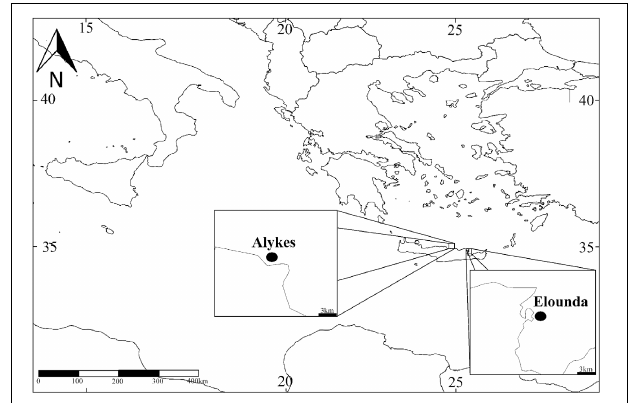
FIGURE 1 | Map of the study sites, located in Crete: Alykes in the central part of the island and Elounda in the eastern part.